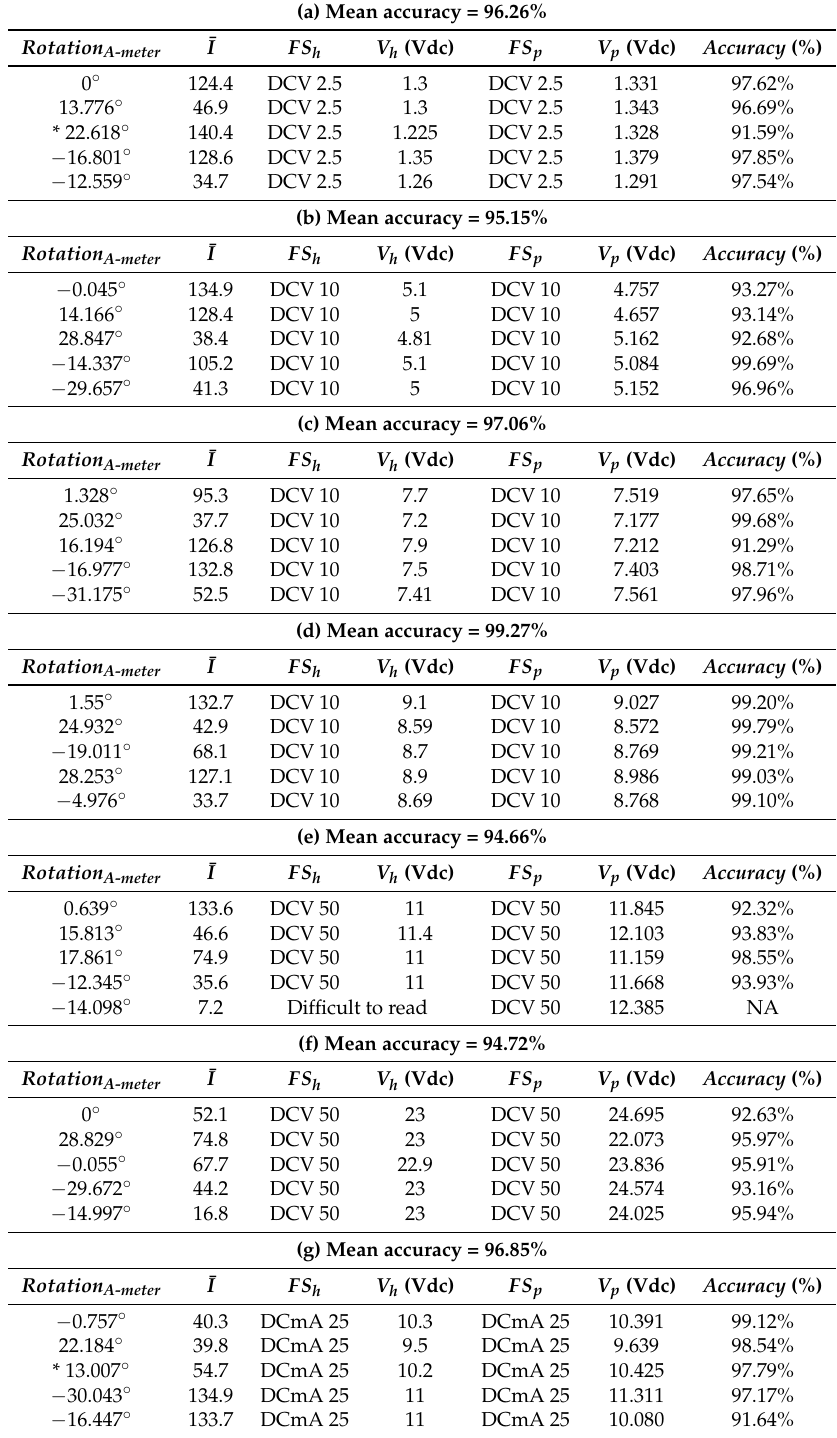
Table 7. Results from using the A-meter YF-370A with function select (a) “DCV 2.5” to measure the 1.5 Vdc battery, (b) “DCV 10” to measure the 5 Vdc adaptor, (c) “DCV 10” to measure the 7.5 Vdc adaptor, (d) “DCV 10” to measure the 9 Vdc battery, (e) “DCV 50” to measure the 12 Vdc adaptor, (f) “DCV 50” to measure the 24 Vdc adaptor, and (g) “DCmA 25” to measure the DC current of the 1.5 V